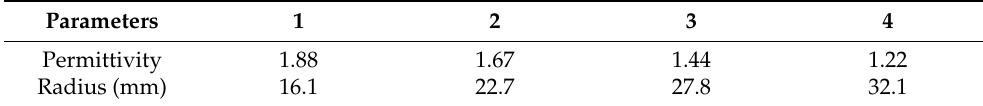
Table 1. Proposed GRIN lens design parameters.